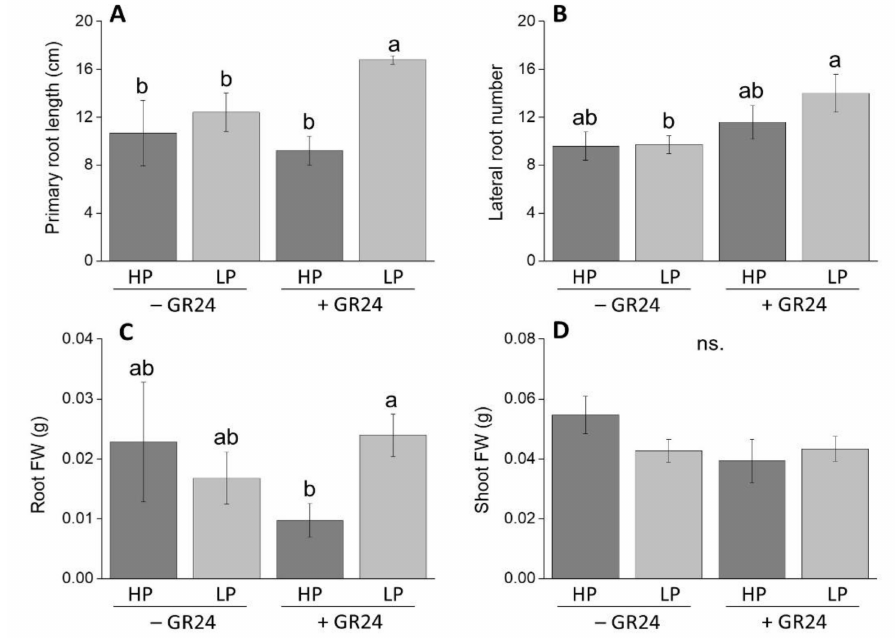
Figure 1. Main biometrics of two-week-old wild-type (WT) seedlings grown either in a standard MS (high P, HP) or in Pi-deprived conditions (low P, LP), with ( + GR24) or without ( − GR24) 5 µ M rac -GR24: ( A ) primary root length; ( B ) number of lateral roots; ( C ) root fresh biomass; ( D ) shoot fresh biomass. Each column represents the average of three ( C , D ) to six seedlings ( A , B ) with standard error. Statistical significance of di ff erences between means is indicated by di ff erent letters above bars ( p ≤